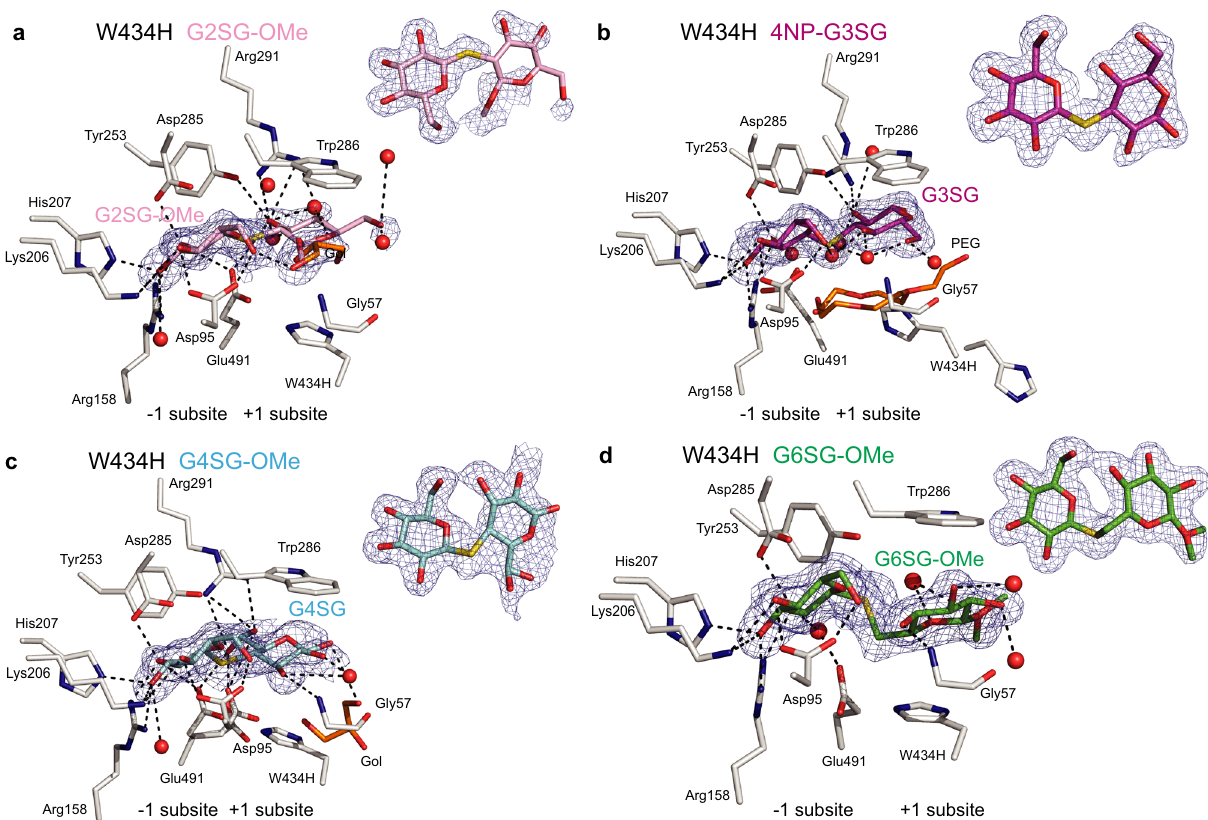
Fig. 4 | Thio-saccharide analogues are bound in the active site of the HvExoI W434H mutant. a Thio-sophoroside (G2SG-OMe, pink); b thio-laminaribioside (4NP-G3SG, magenta); c thio-cellobioside (G4SG; cyan); and d thio-gentiobioside (G6SG-OMe, green) moieties are bound across the − 1 to +2 subsites. Panels a to d contain derived difference 2m| F o |-D| F c | electron density maps (blue) of thio-